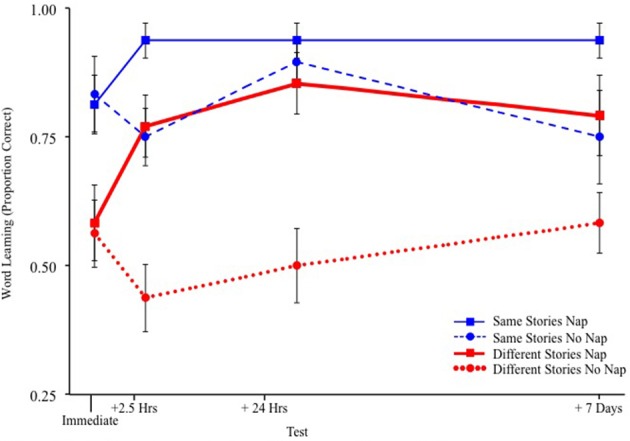
Word learning results from Williams and Horst (2014).